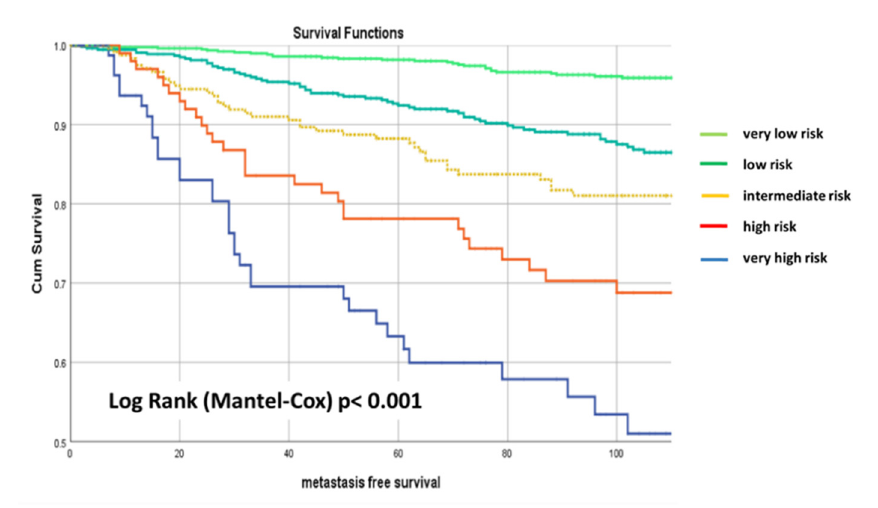
Figure 2. Kaplan-Meier metastasis-free survival (MFS) curves of the validation set stratified by BRENDA-Score (Dachau DB) with 110 months follow up. Very low risk = light green, low risk = green, intermediate risk = yellow, high risk = orange, very high risk = blue line.